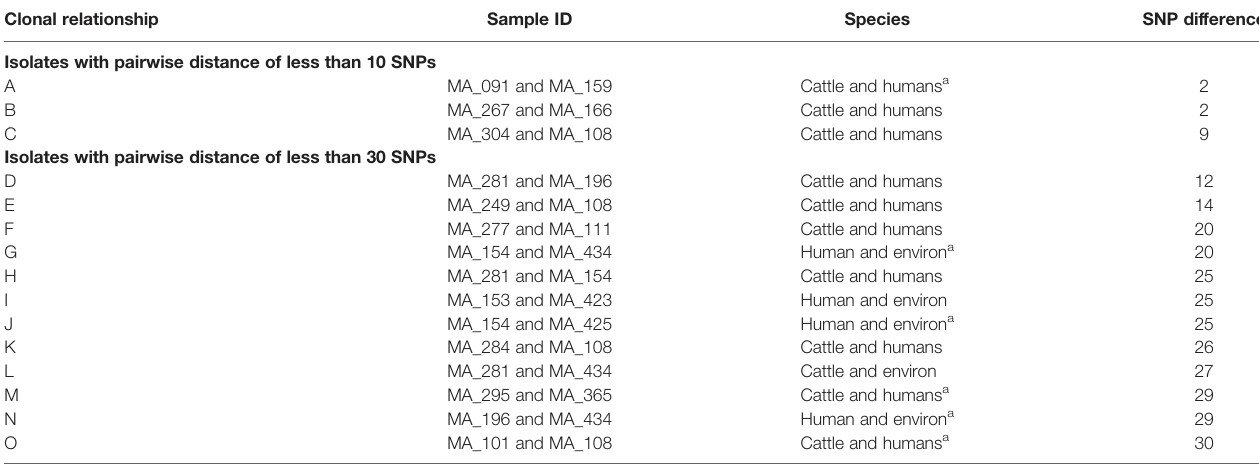
TABLE 3 | Clonal relationship between ESBL-EC isolates from different sources. Clonal